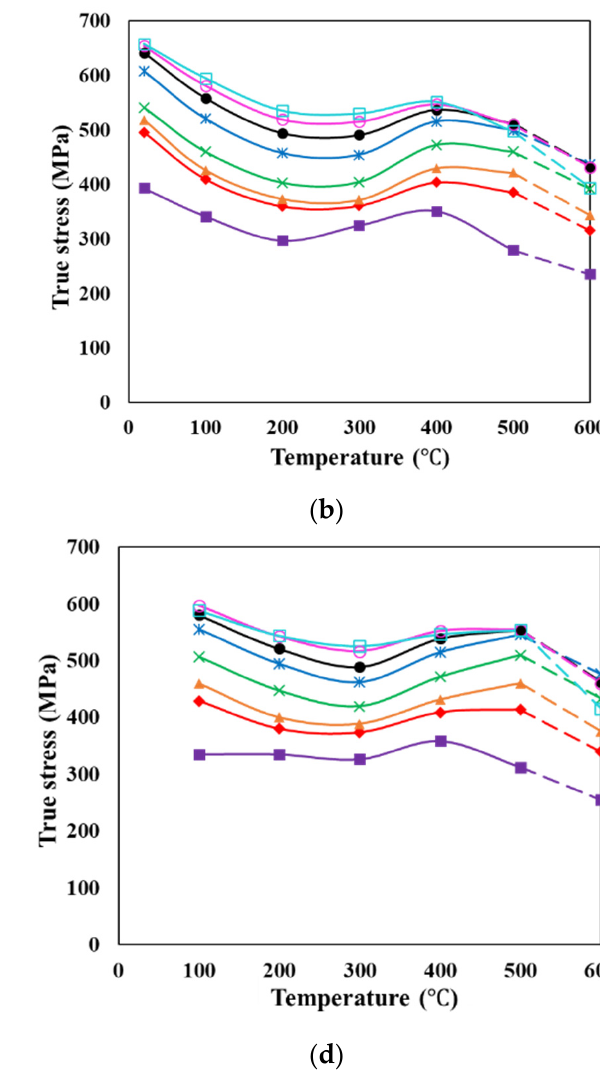
Figure 10. Variation in flow stress with temperature at strain rates of: ( a ) Strain rate: 1/s; ( b ) Strain rate: 5/s; ( c ) Strain rate: 10/s; ( d ) Strain rate: 20/s.